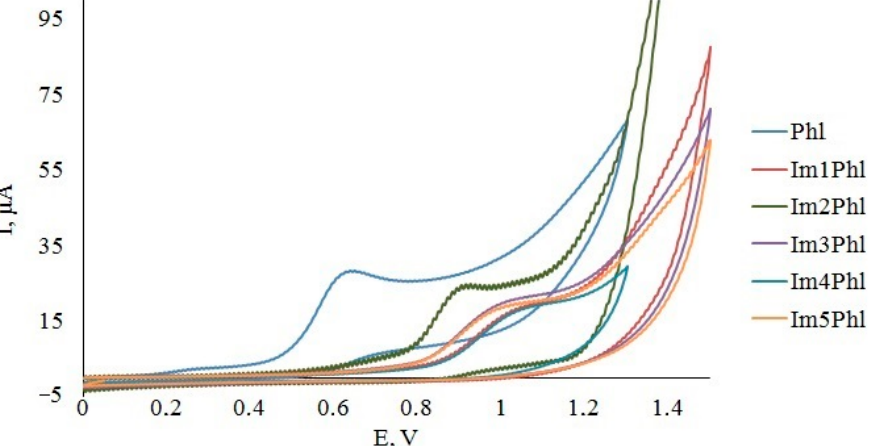
Figure 4. Cyclic voltammograms of phloroglucinol and imidazolylphloroglucinol recorded on the glassy carbon electrode (C = 1 mmol/dm 3 ; background: 0.1 mol/dm 3 KCl; scan rate 0.1 V/s).